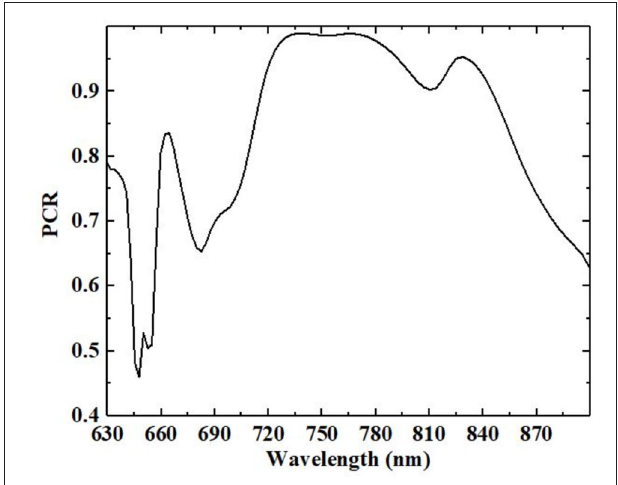
FIGURE 3 | The polarization conversion ratio (PCR) of x -polarized light with backward propagation.